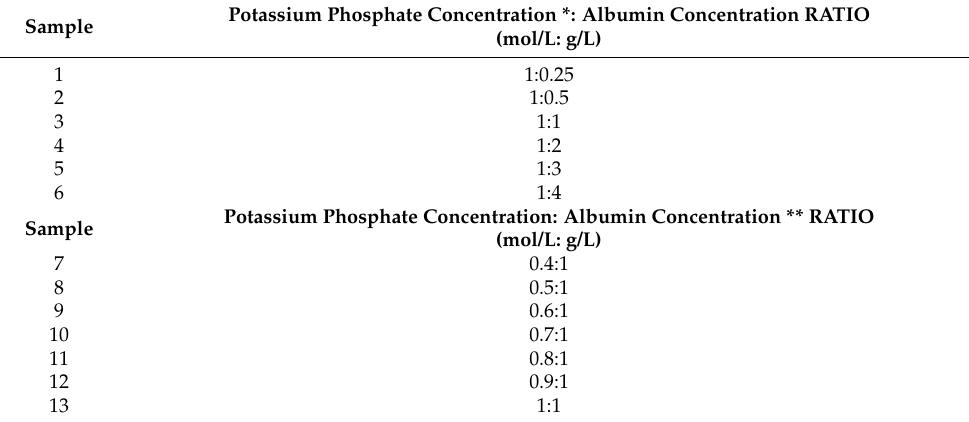
Table 2. The synthesis conditions of albumin-based carriers with varying concentrations of albumin and salting-out agent